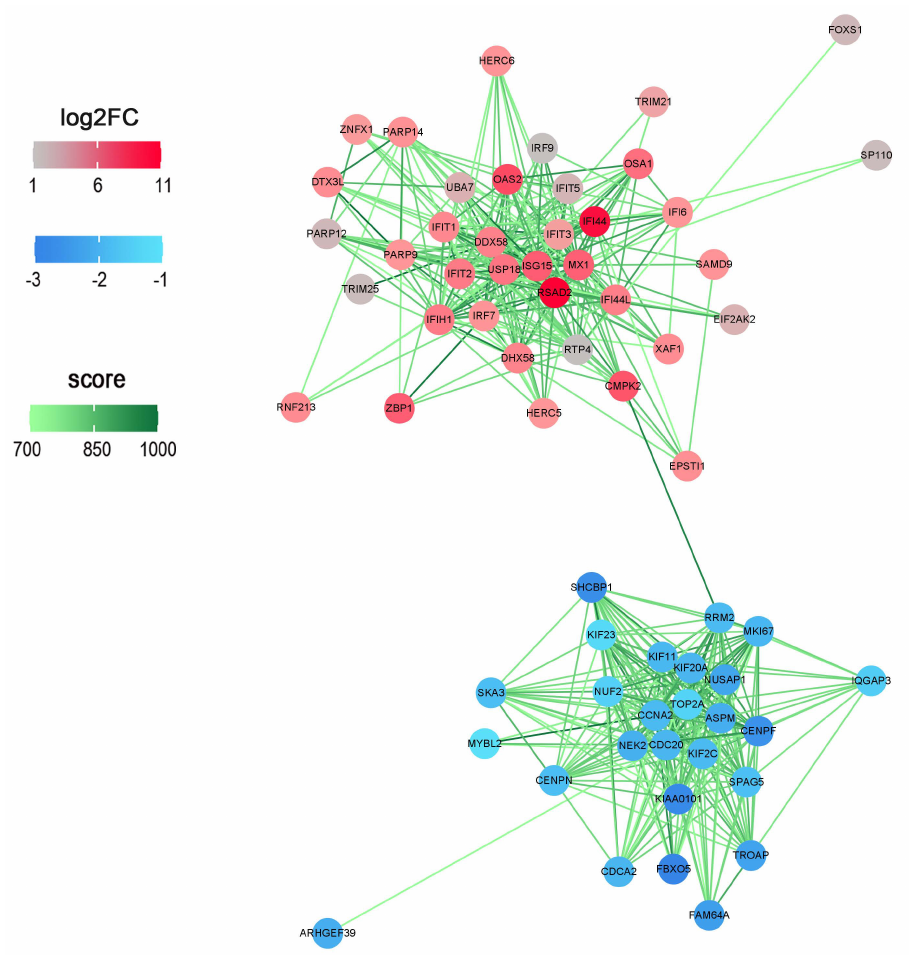
Figure 5. PPI network of DEGs coding proteins. The green scale indicates the STRING database prediction score; the red scale and the blue scale represent the up-regulated and down-regulated DEGs in the mRNA-Seq results,